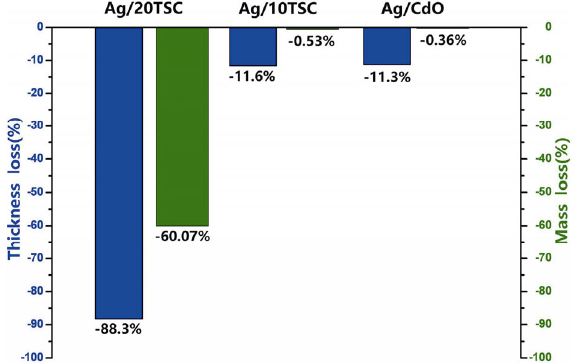
Fig. 11 Loss of thickness (blue blocks) and mass (green blocks) in these contacts after electric arc